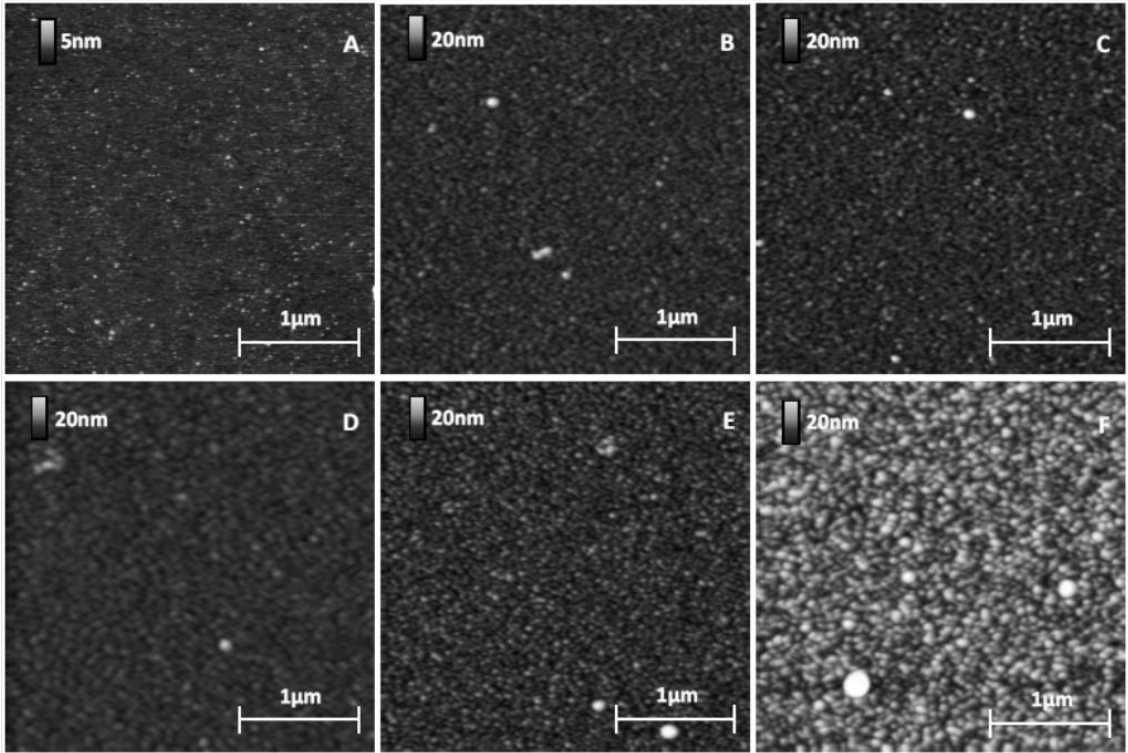
Figure 3. GaAs surface images before ( A ) and after protein grafting for several chemical interfaces: unfunctionalized ( B ); 0% MHDA ( C ); 100% MHDA ( D ); 3% MHDA ( E ); and 10% MHDA ( F